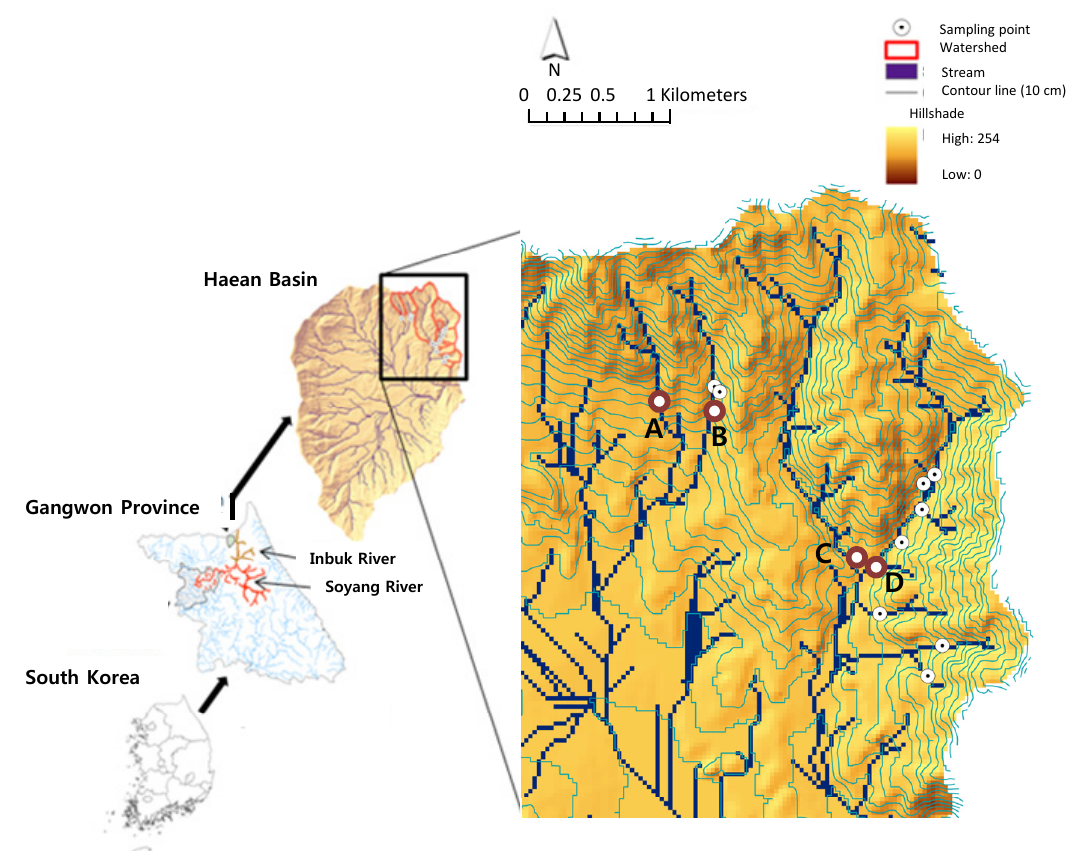
Figure 1. Stream water sampling locations for routine bi-weekly monitoring at the four streams (A–D). The location of the V-notch weir and the weather station within watershed A is indicated by the letter of